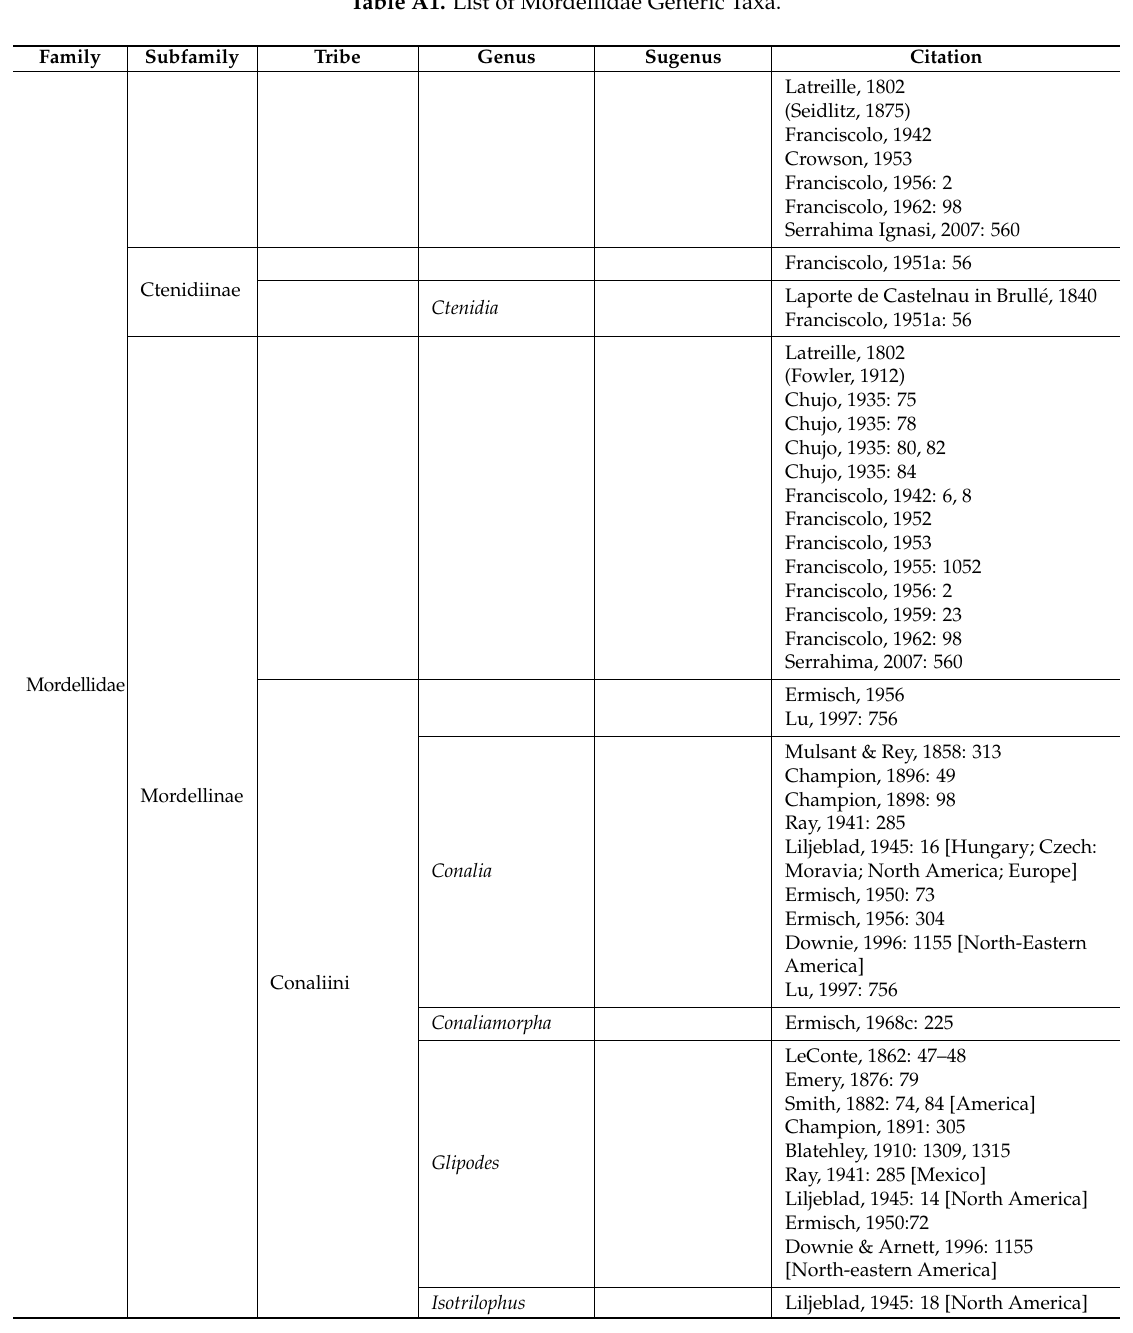
Table A1. List of Mordellidae Generic